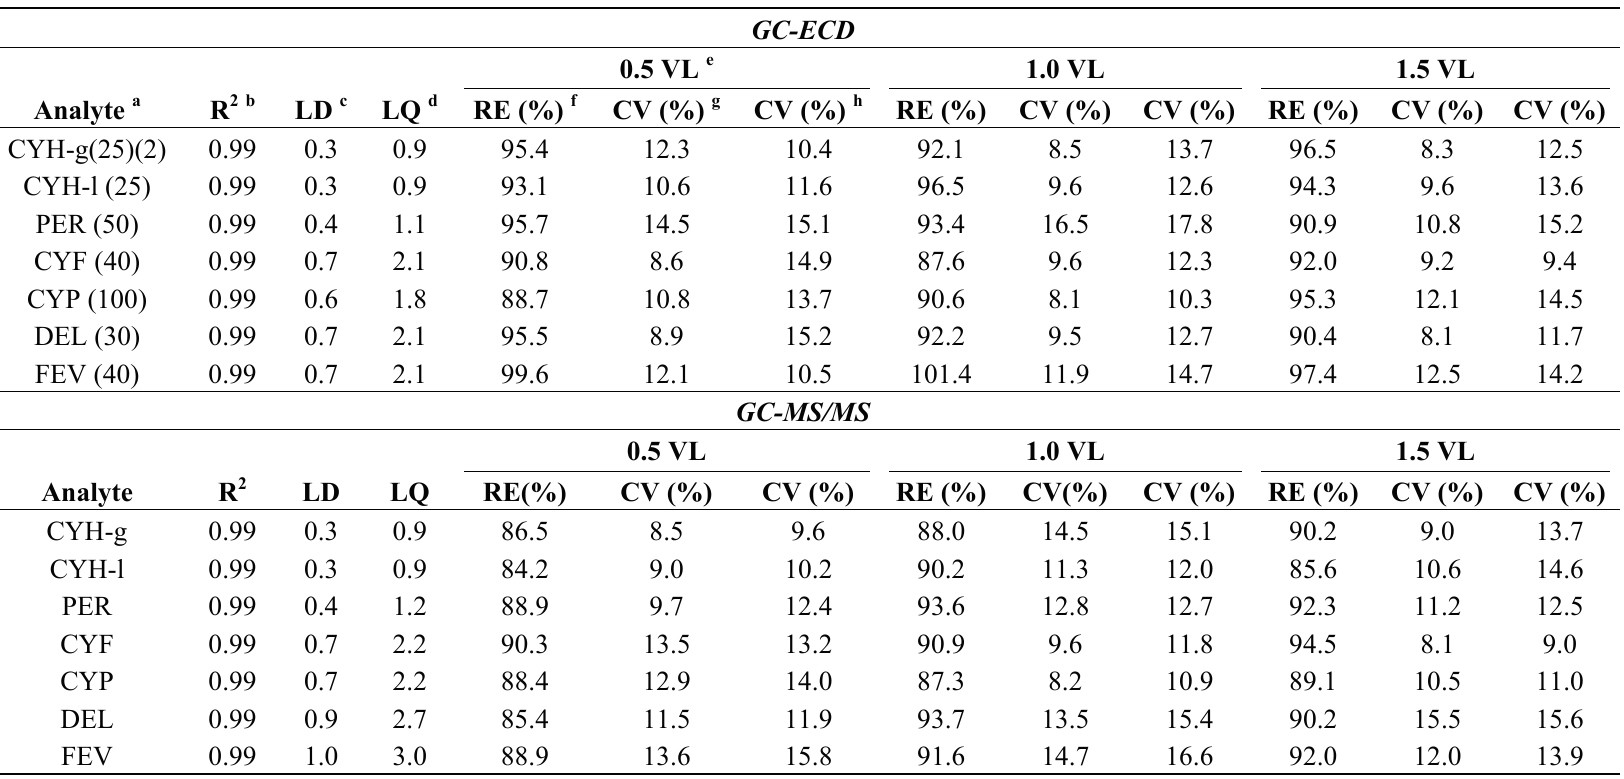
Table 5. Summary of validation